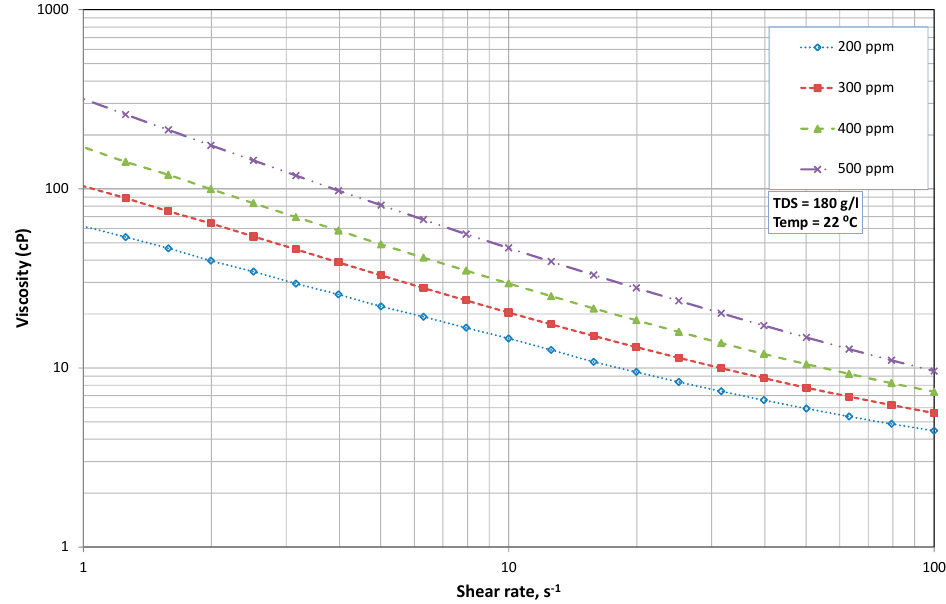
Figure 1. E ff ect of varying the molar concentration of the screening samples on the biopolymer solution viscosity.